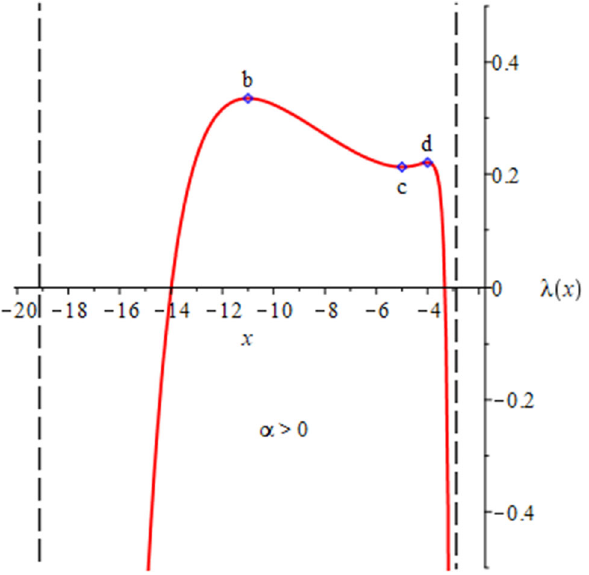
Fig. 1 The function λ( x ) for α > 0, m = 12 and l = 3 [21]